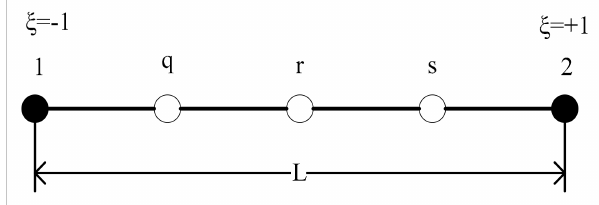
Figure A1. Inverse finite element geometry and nodal